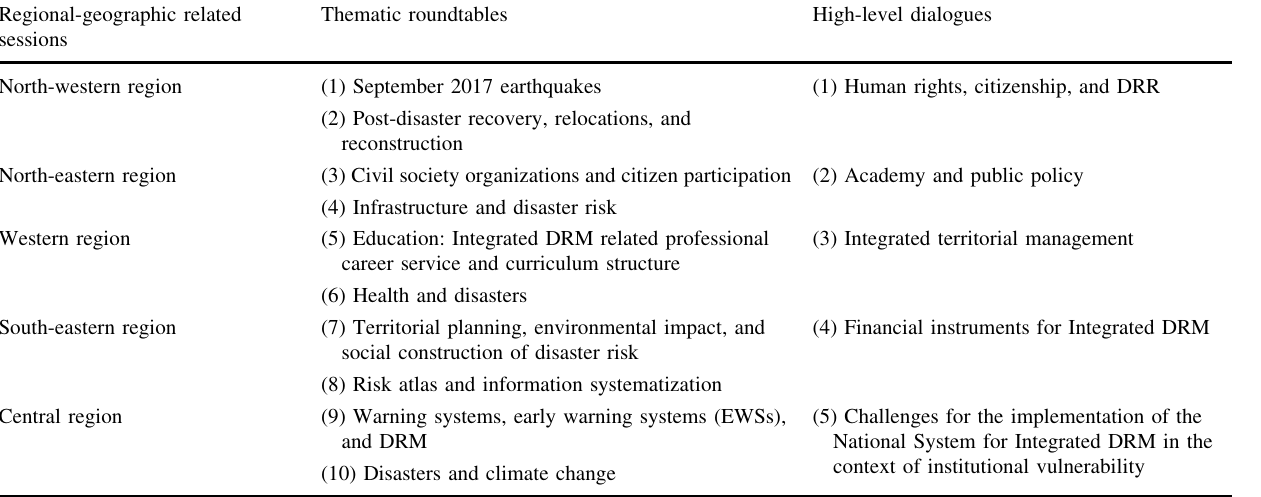
Table 1 Sessions of the first MuSe-IDRiM Conference Regional-geographic related